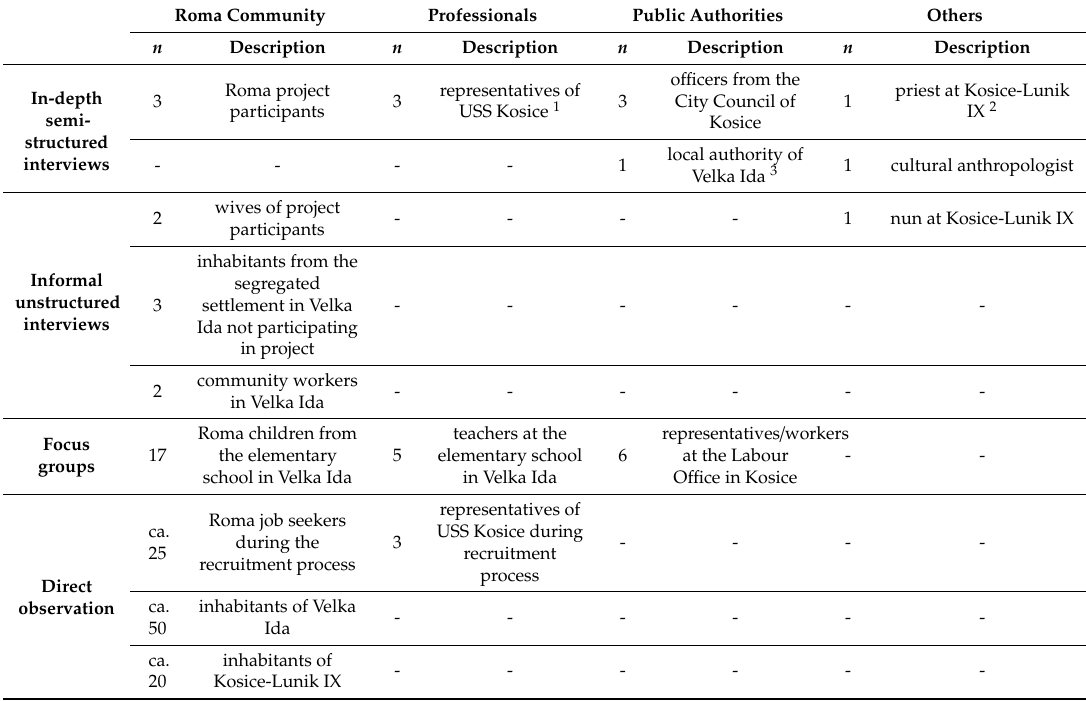
Table 1. Characteristics of the samples participating in the various data collection